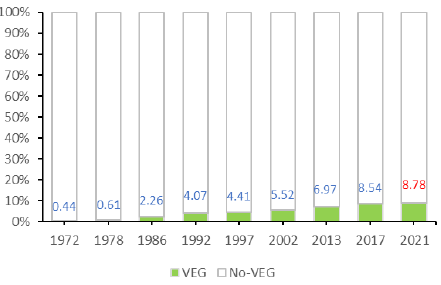
Figure 5 . The percentage of VEG areas in all three study areas from 1972 to 2021.